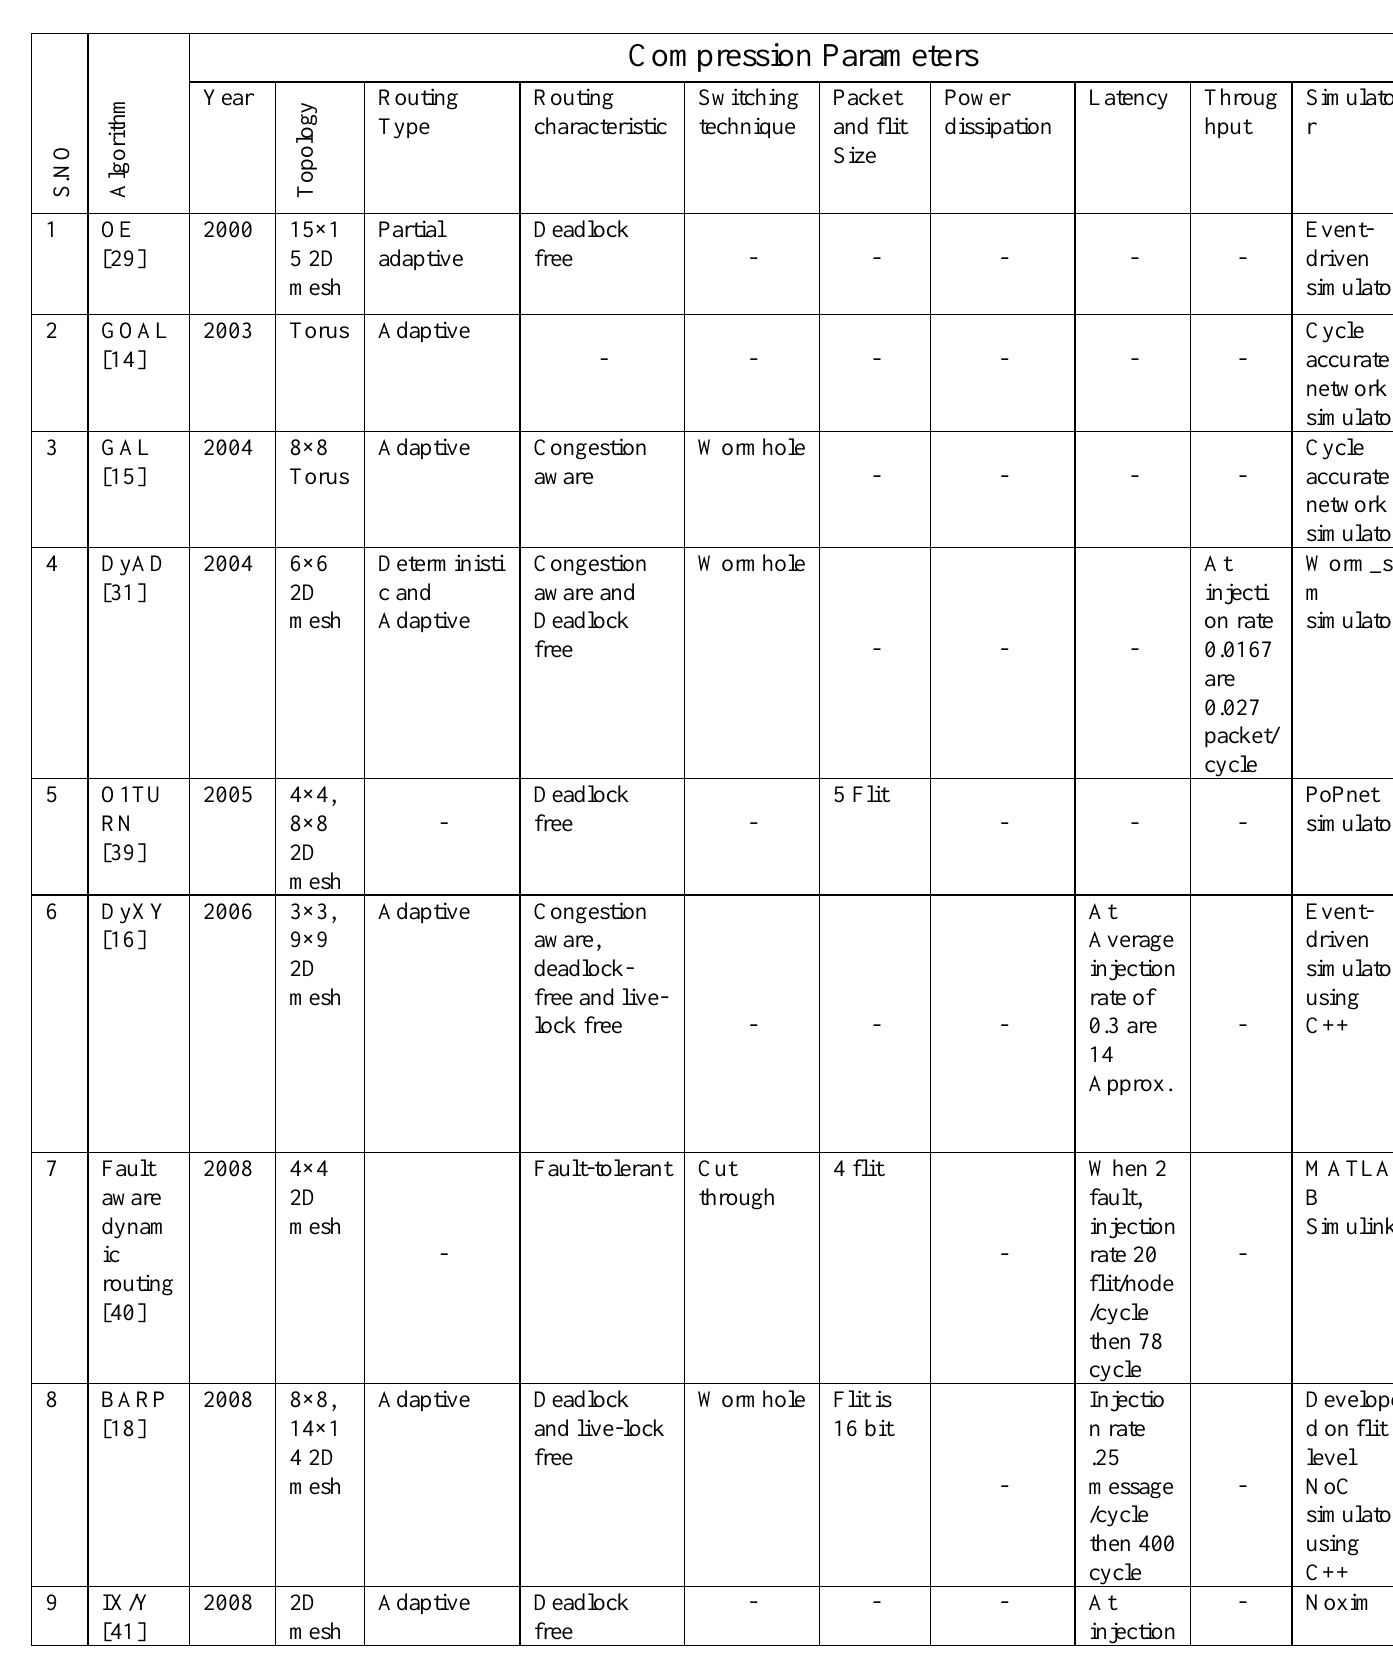
Table 1. NoC Routing